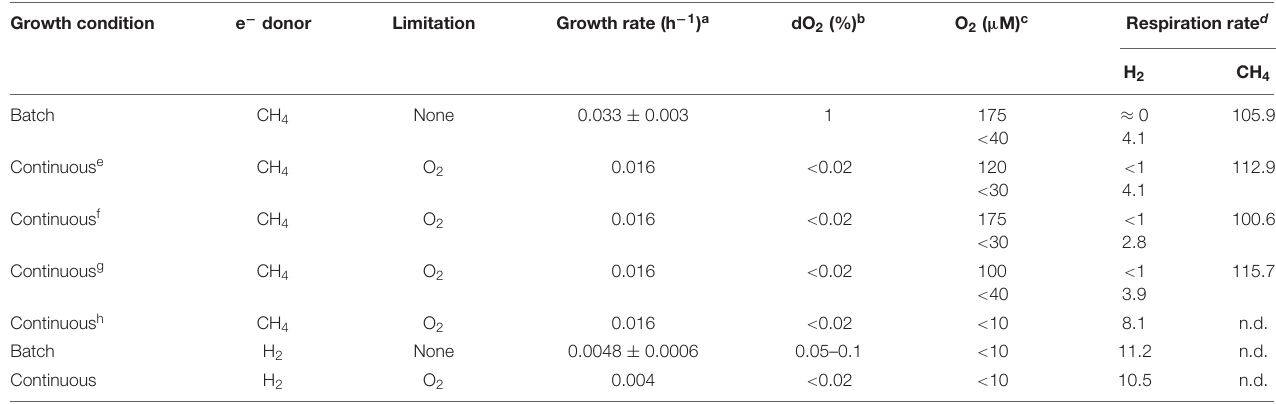
TABLE 1 | Oxygen respiration rates of Methylacidimicrobium tartarophylax 4AC cells with CH 4 or H 2 . Growth